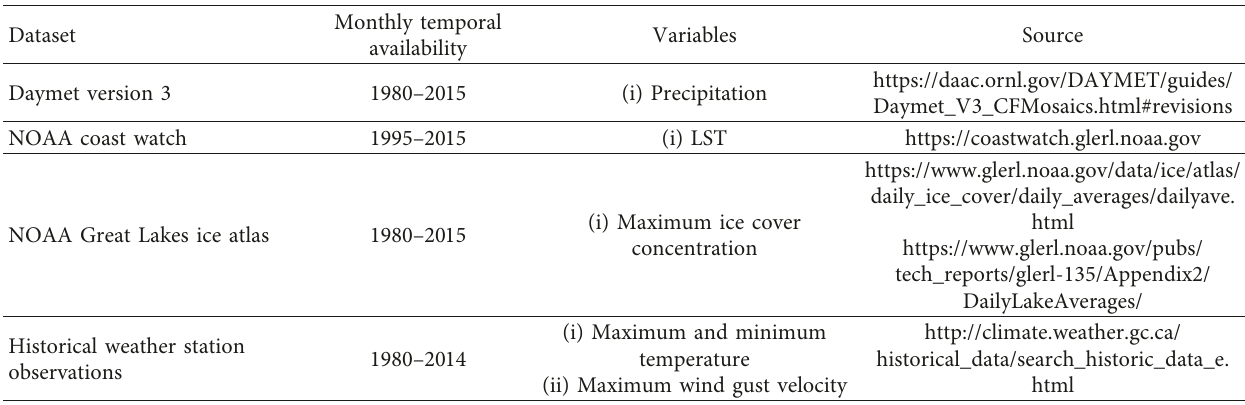
Figure 1: Map of the Laurentian Great Lakes, depicting the geographic boundaries and Canadian leeward shores (snowbelts) of Lakes Superior and Huron analysed in this study. Table 1: List of datasets with associated variables, sources, and temporal availability used in this